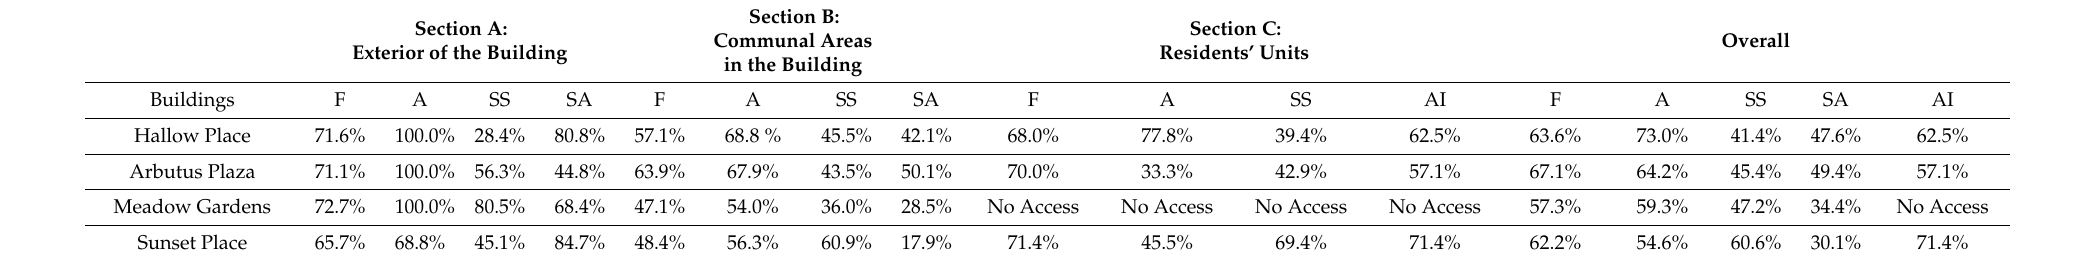
Table 2. Sectional scoring of AIRP concepts per THP